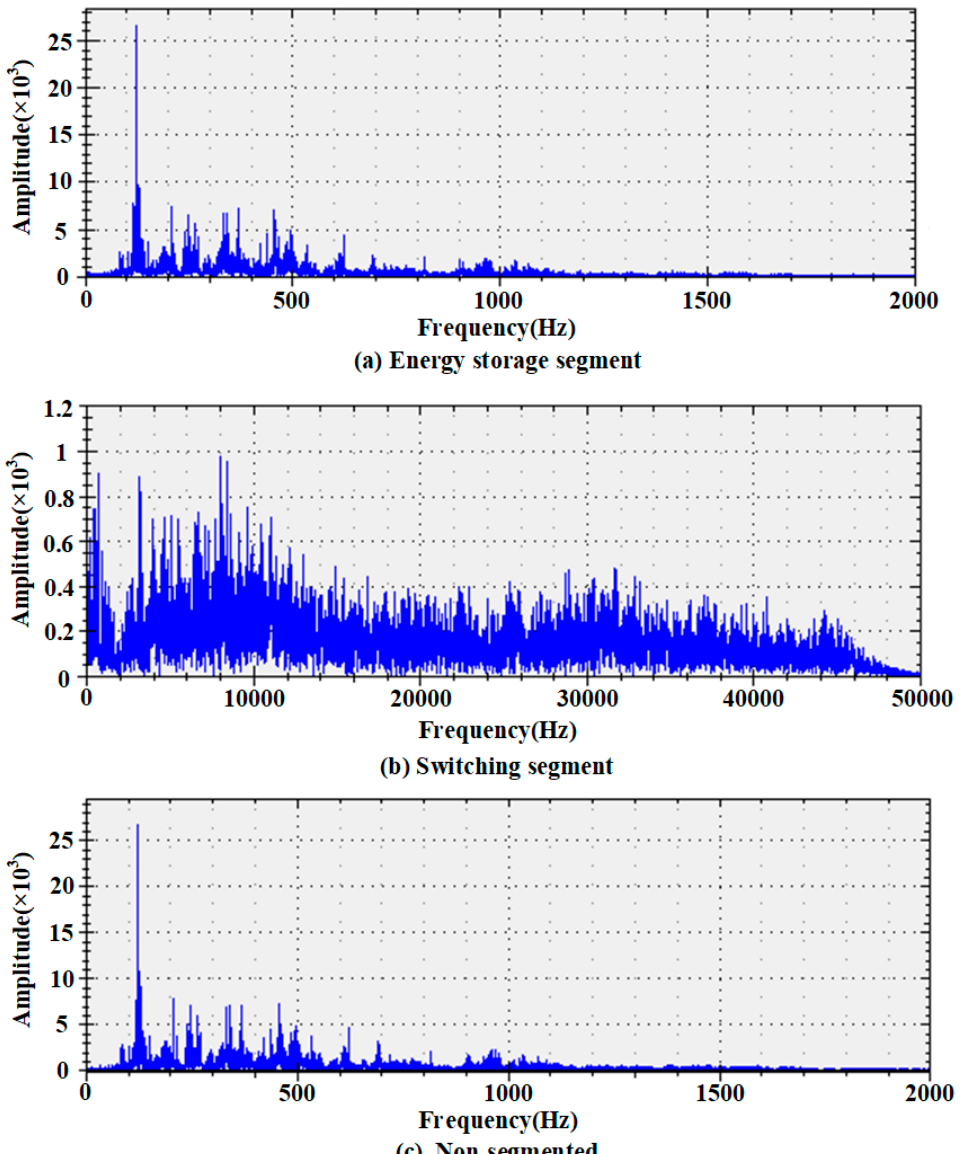
Figure 5. Vibration signal spectrum of the